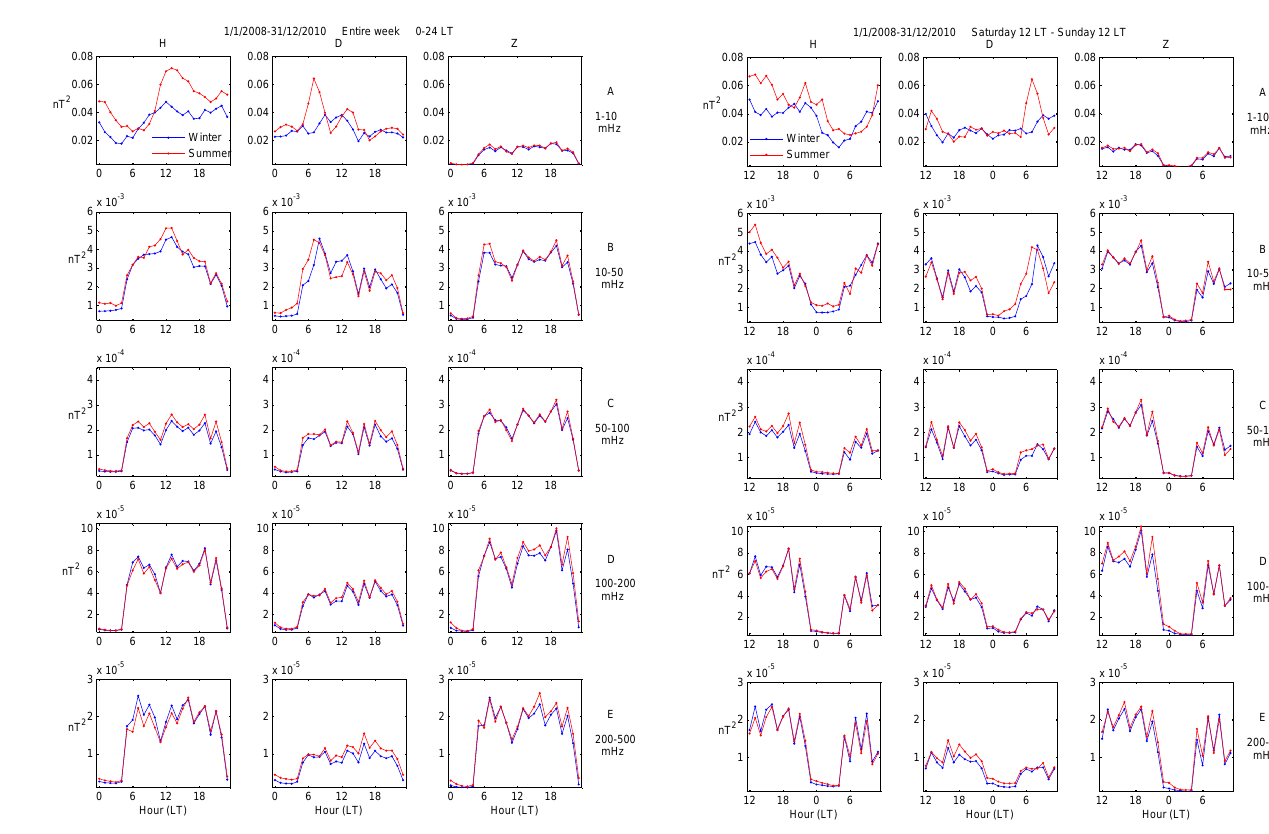
Figure 3. The same as in Fig. 2 but for the weekend (Saturday 12:00LT–Sunday